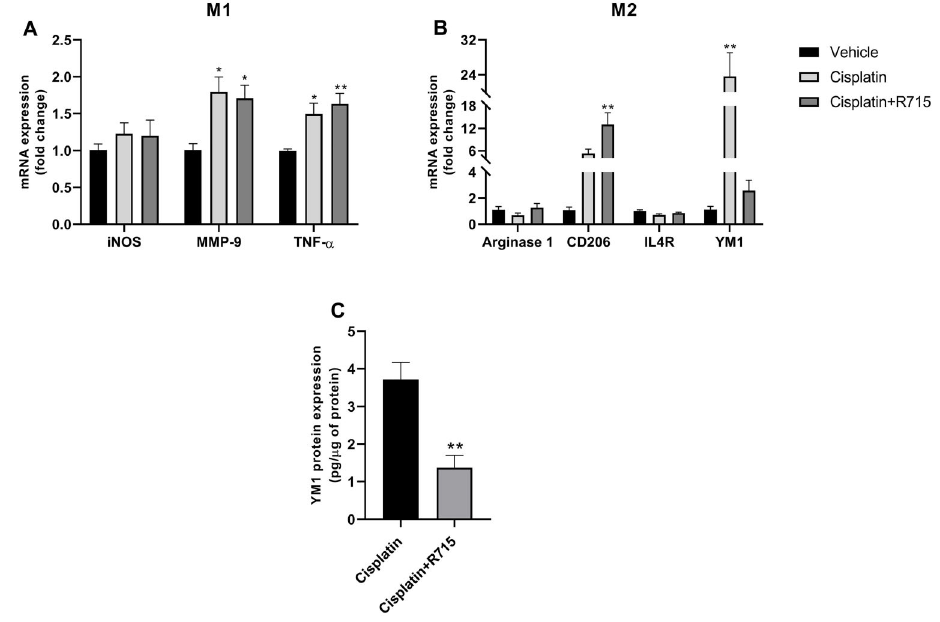
Figure 8. Kinin B1 receptor antagonism did not increase YM1 expression. Renal mRNA expression of M1 markers ( A ), M2 markers ( B ), and renal YM1 ( C ) protein levels. Data are reported as means ± SE (n=6 per group). *P o 0.05, **P o 0.01 compared to the vehicle group (one-way ANOVA followed by post hoc Tukey ’ s